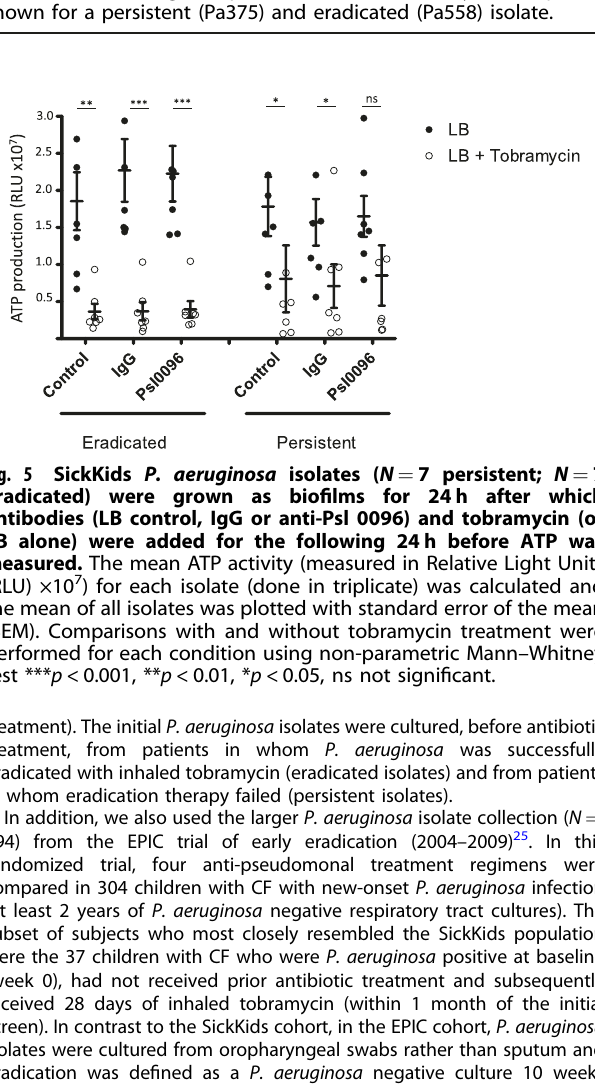
Fig. 4 SickKids P. aeruginosa isolates ( N = 7 persistent; N = 7 eradicated) were grown as bio fi lms for 24 h after which antibodies (LB control, IgG or anti-Psl 0096) and tobramycin 1000 µg/ml (or LB alone) were added for the following 24 h before imaging was performed. A The mean bio fi lm volume (measured in µm 3 ) for each isolate (done in triplicate) was calculated and the mean of all isolates was plotted with standard error of the mean (SEM). Comparisons with and without tobramycin treatment were performed for each condition using non- parametric Mann – Whitney test *** p < 0.001, ** p < 0.01, * p < 0.05, ns not signi fi cant. B In the presence of tobramycin, aggregation was measured using bio fi lm surface to volume ratio. The mean bio fi lm surface to volume ratio (µm 2 /µm 3 ) was calculated for each isolate (done in triplicate) and the mean of all isolates was plotted with standard error of the mean (SEM). Comparisons to IgG control were performed for each condition using non-parametric Mann – Whitney test *** p < 0.001, ** p < 0.01, * p < 0.05, ns: not signi fi cant. C Representative images are shown for a persistent (Pa375) and eradicated (Pa558) isolate.